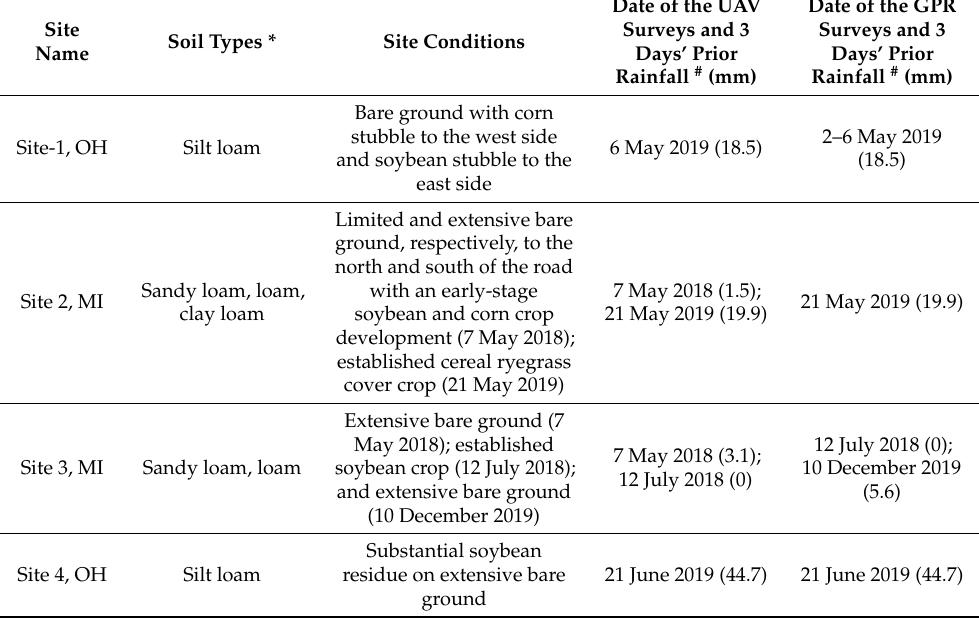
Table 1. Summary of the study sites’ location, soil types, site survey conditions, dates of the un- manned aerial vehicle (UAV) imagery and ground penetrating radar (GPR) surveys, and cumulative rainfall values (in brackets) three days prior to the